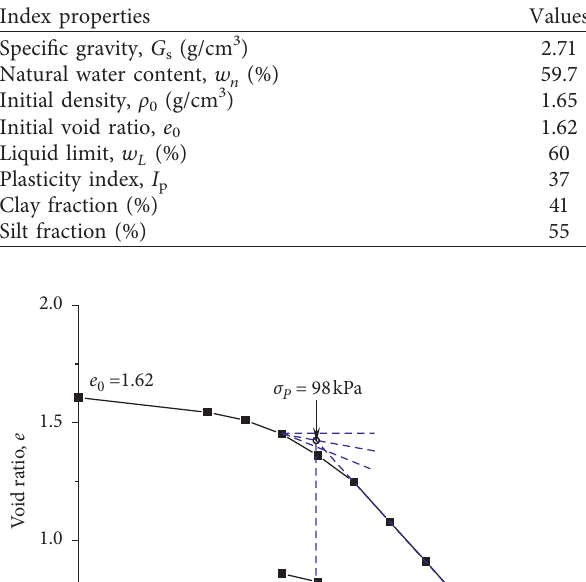
Table 1: Physical properties of Wenzhou soft clay.